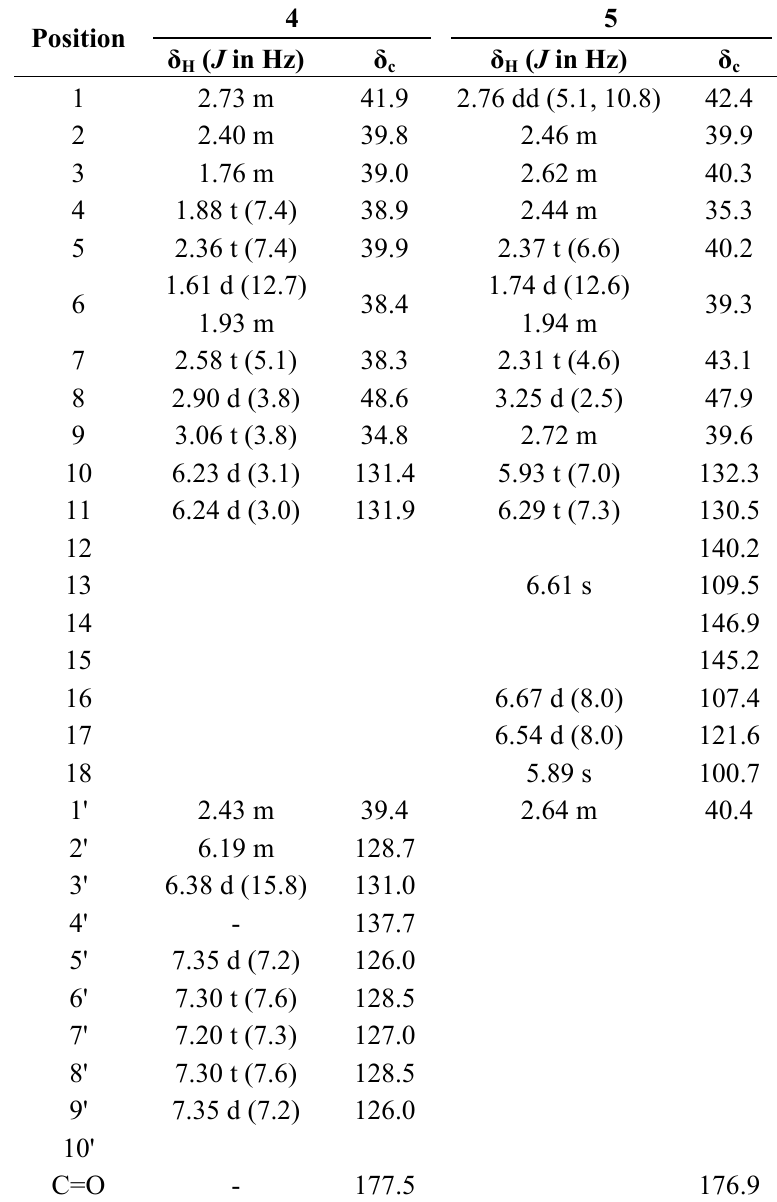
Table 2. 1 H (600 MHz) and 13 C (150 MHz) NMR data of compounds 4 and 5 (CDCl